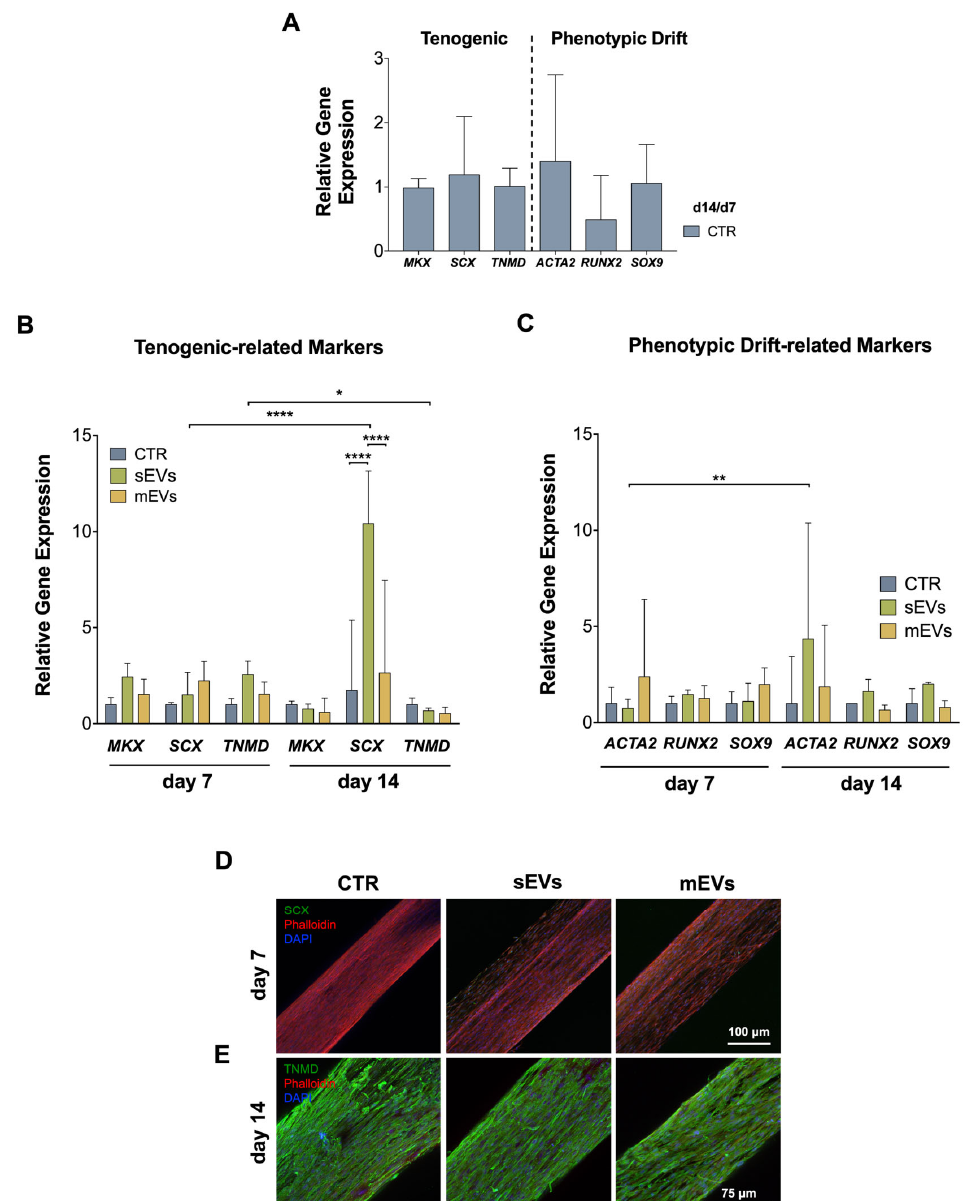
Figure 4. EVs effect on phenotypic-drift of hASCs encapsulated in yarns. ( A ) Control day 14/control day 7 ratio of tendon markers. ( B ) Gene expression analysis of tenogenic markers MKX, SCX, and TNMD, and ( C ) tenogenic drift markers ACTA2, RUNX2, and SOX9 after 7 and 14 days of culture. Gene expression results are presented as fold changes with respect to the control group at each time point. Statistical significance: * p < 0.05, ** p < 0.01, **** p < 0.0001. ( D ) Representative confocal images of immunolabelled samples against SCX (green) after 7 d and ( E ) against TNMD (green) after 14 d of culture. Images were counterstained with DAPI (cells nuclei, blue). Scale bars: 75 μ m and 100 μ m, respectively.